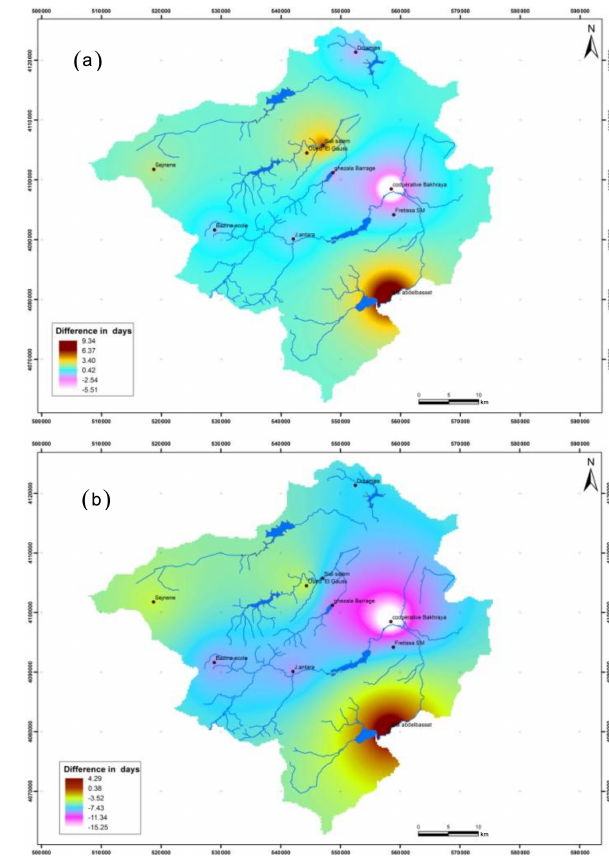
Figure 7. Differences between maximum dry spells observed and estimated: (a) observed-estimated using Gumbel distribution; (b) observed-estimated using E